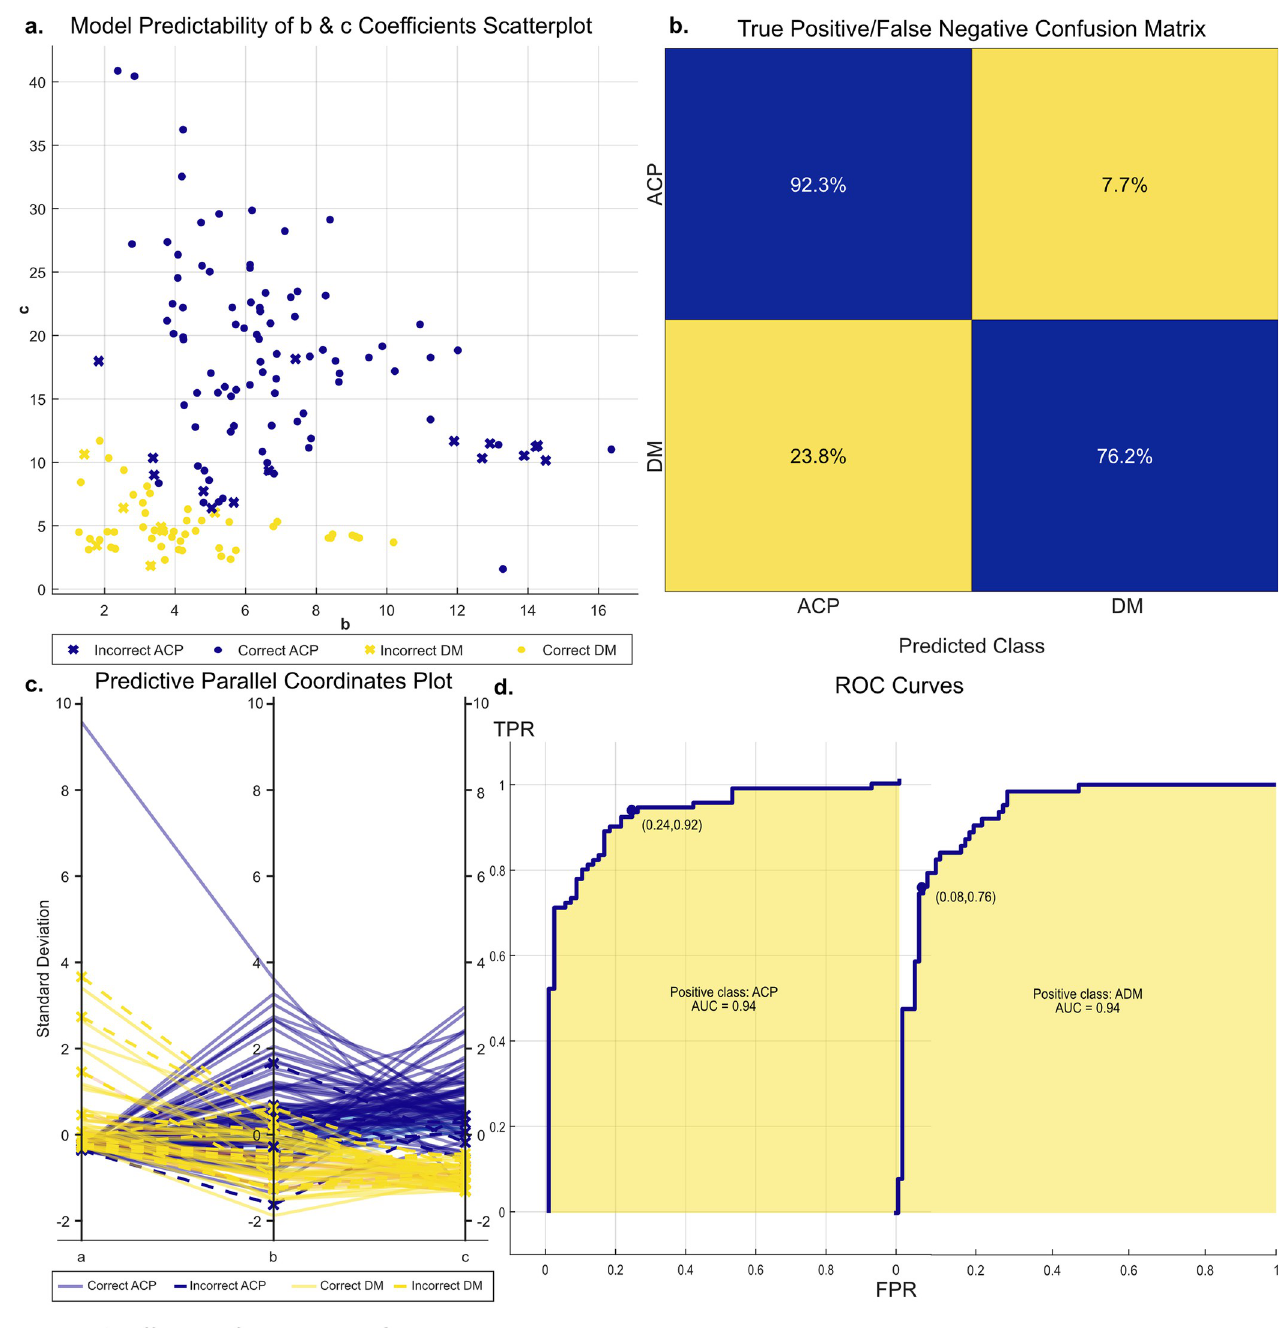
Fig 3. Efficacy of optimizable SVM. (A) Scatterplot of the movement clusters based on coefficients b and c of the parabolic fits, with arm chain pulls (CP) in blue and hand clenches (HC) in yellow. (B) True positive and false negative rates for predictive ability of the SVM as represented by a confusion matrix. (C) Parallel coordinates plot of the predictive ability of the model, highlighting the spread of coefficient values. (D) Receiver operating characteristic (ROC) curves between each class of the binary classifier. resulted in 46.15–100.00% of videos per patient exhibiting > 95% accuracy at tracking their motor behaviors (Table 2). On a subset (10%) of video recordings, the automated extraction script exhibited 80% accuracy at isolating movement epochs without manual intervention. 771